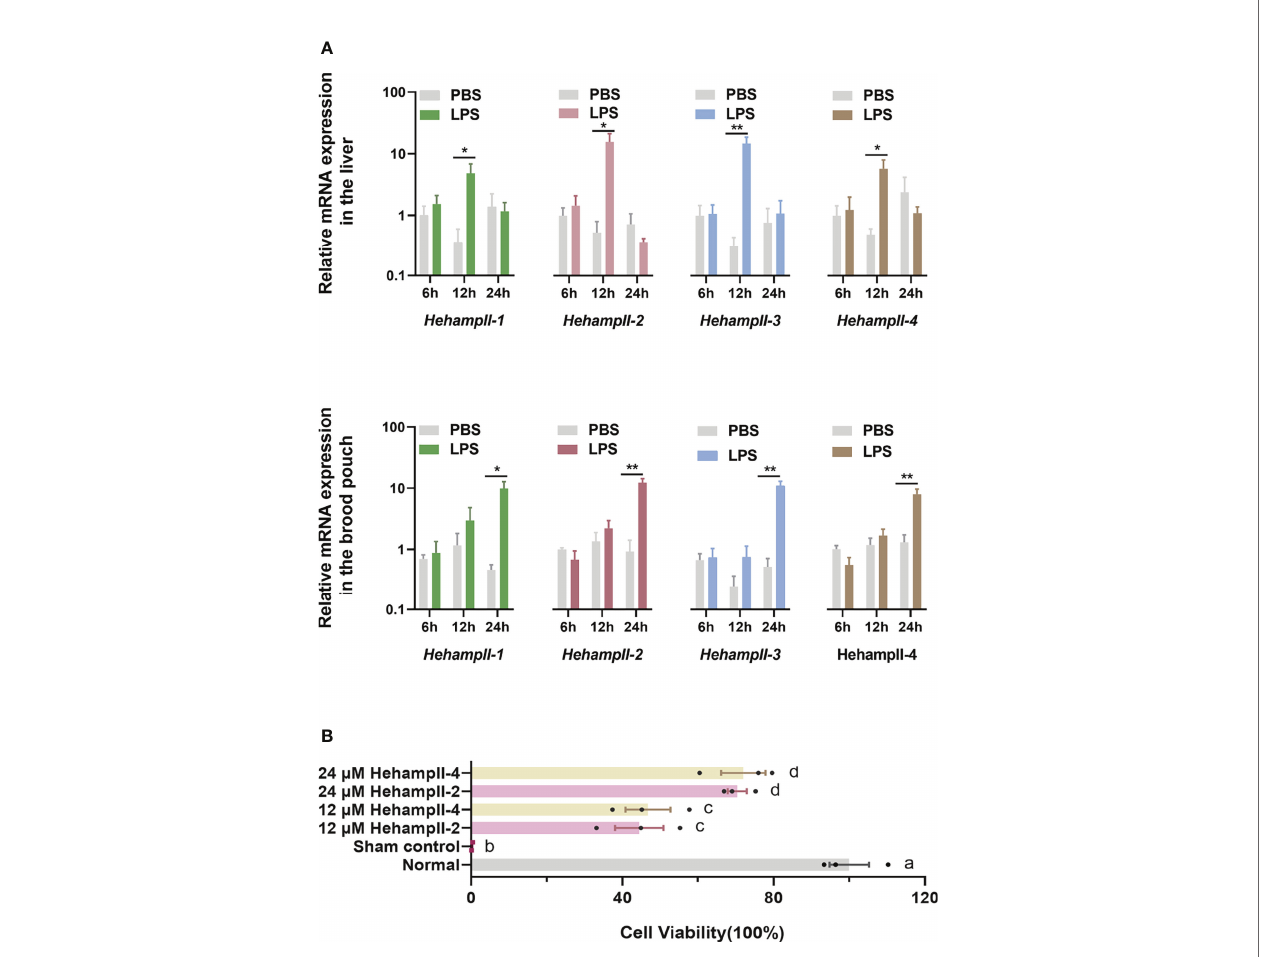
FIGURE 3 | (A) In vivo , relative expression of seahorse HehampIIs in the placenta of the brood pouch and liver were upregulated in response to the lipopolysaccharides (LPS) challenge, PBS: phosphate-buffered saline. (mean ± SEM, n=5; *, p < 0.05; **, p < 0.01) (B) In vitro , the two seahorse HehampII mature peptides could rescue the death of seahorse embryonic cell caused by supernatant of Vibrio. Different lowercase letters indicate signi fi cant differences between them (mean ± SEM, n=3; p <